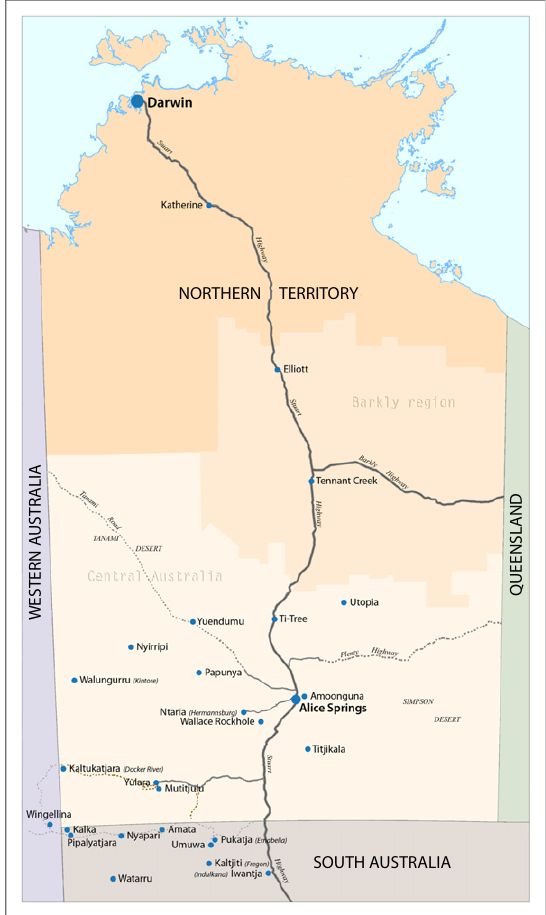
Figure 2. Map of Northern Territories and cross-border